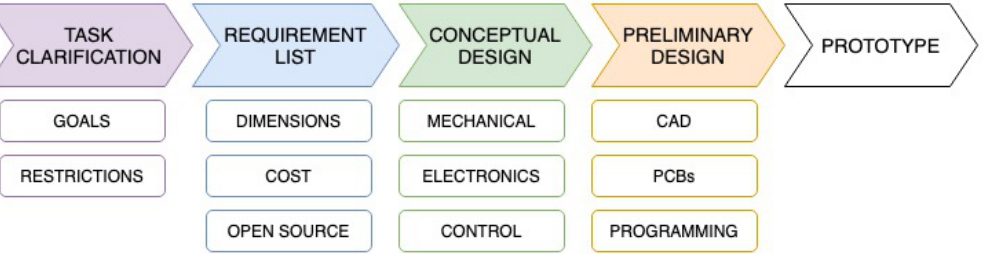
Figure 2. Engineering